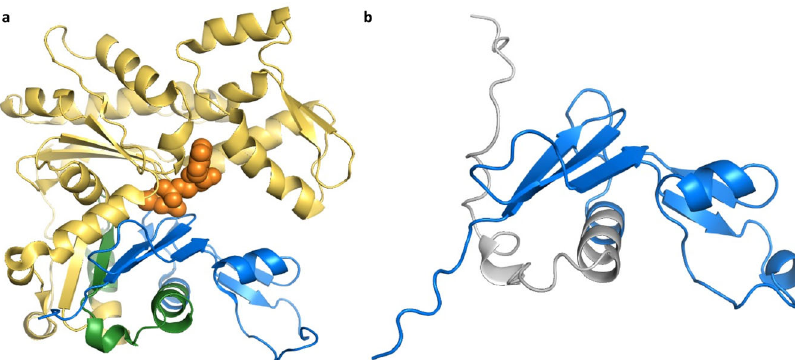
Fig. 4 The effect of ACTG2 alternative splice event on protein structure. a The sequence of alternative isoform from the novel exon mapped onto the structure of chicken smooth muscle actin (PDB: 3W3D, 28). The region that is maintained in the alternative isoform is shown in blue, while the 34 residues that would be replaced by the novel primate exon with the pathogenic variant are shown in green. The remainder of the structure (in yellow) would be lost from this presumed protein. The ATP and calcium bound by the chicken actin protein (lost in the alternative isoform) are in orange space fi ll. Mapping was carried out using HHPRED 47 . b A model of the same truncated ACTG2 isoform generated by AlphaFold 45 . The maintained sequence is in blue, the novel predicted region is in grey. Despite the AlphaFold prediction, the substituted sequence is unlikely to fold into an extended helix, and will certainly not bind ATP. Both images were generated with PyMol.